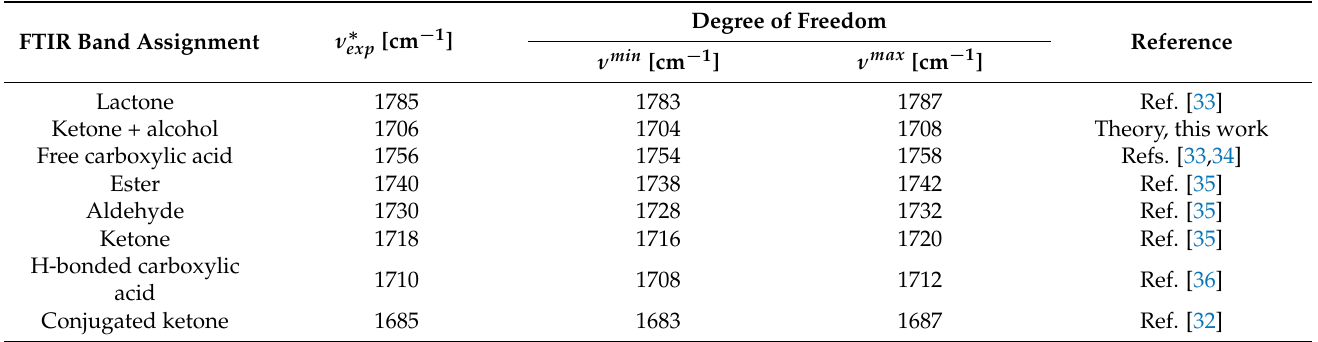
Table 2. FTIR band assignments in the carbonyl area. We note by ν ∗ exp the assigned experimen- tal wavenumber (from the reference in the last column) and by ν min and ν max the minimum and maximum values allowed in the deconvolution